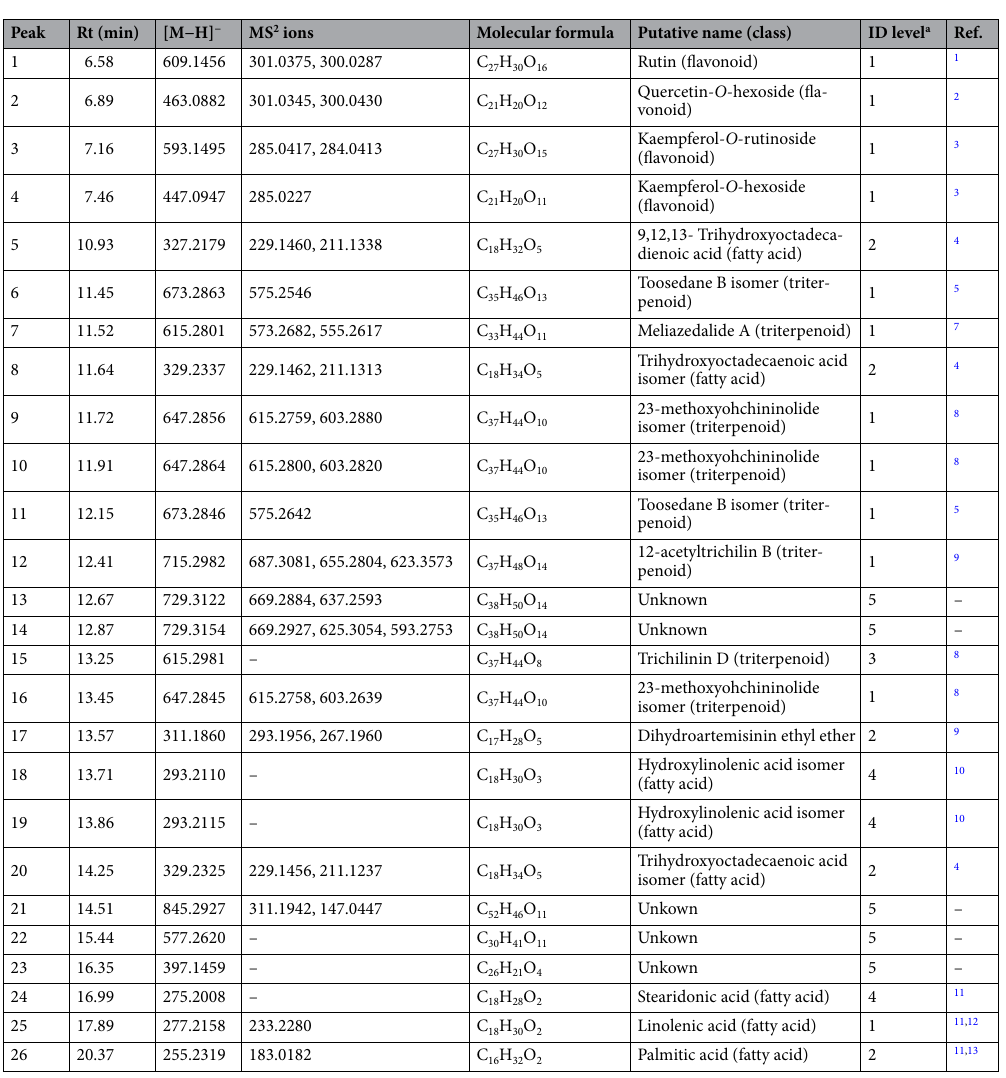
Table 4. Compounds putatively identified of extract in ethyl acetate fraction from Melia azadirachta leaves by UPLC-ESI-QTOF-MSE in negative ionization mode. a Identification level: 1. Exact mass, MS/MS (Mass Spectrometry) fragments and occurrence; 2. Exact mass and MS/MS fragments; 3. Exact mass and occurrence; 4, Exact mass; 5. Not